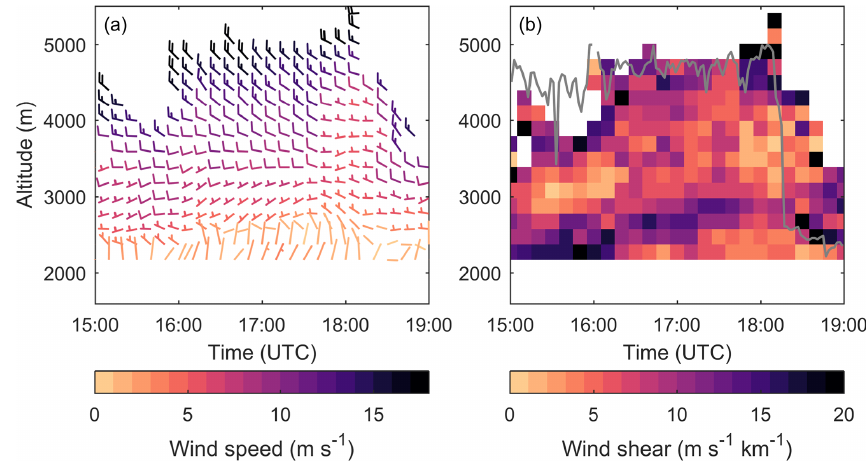
Figure 3. Observations of the wind speed and wind direction (a) and of the wind shear (b) measured by the radar wind profiler located at Wolfgang. The vertical wind shear ( s ) was calculated from the wind profiler observations, considering changes in the scalar wind speed and (cid:16) (cid:17) s = (u 2 − u 1 ) · (z 2 − z 1 ) − 1 direction ( u ) between two adjacent height levels ( z ) . The gray line in (b) shows the cloud radar reflectivity contour of − 30dBZ, which indicates the cloud top height.